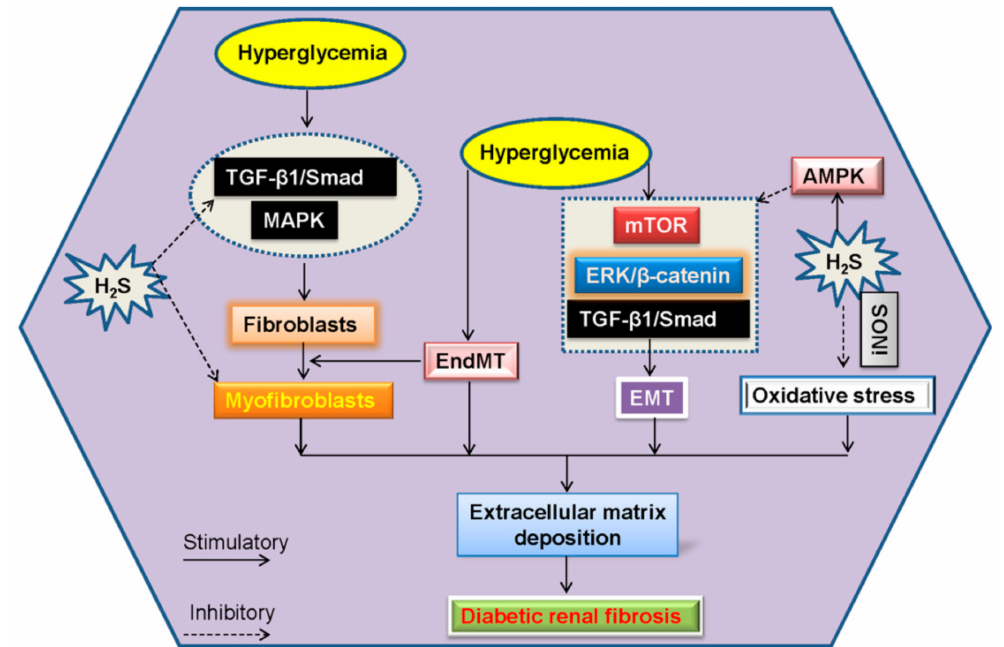
Figure 6. E ff ect of H 2 S on renal fibrosis in diabetic kidneys. Activated fibroblasts may be from resident quiescent fibroblasts via the process of EndMT. H 2 S treatment prevents the di ff erentiation of quiescent renal fibroblasts to myofibroblasts and myofibroblasts proliferation via inhibition of the TGF- β 1 / Smad and MAPK signaling pathways. Blockade of ERK- and β -catenin-dependent pathways may be involved in the protective e ff ect of H 2 S on the formation of EMT in renal tubular epithelial cells. In addition, H 2 S dose-dependently stimulates AMPK phosphorylation and induces its subsequent inhibition of mTORC1 activity. Induction of iNOS, is required for H 2 S to inhibit high glucose-induced oxidative stress and matrix protein generation in renal proximal tubular epithelial cells. EndMT, endothelial-mesenchymal transition; EMT, epithelial mesenchymal transition; TGF- β 1, transforming growth factor- β 1; MAPK, mitogen-activated protein kinase; mTORC1, mammalian target of rapamycin complex 1; ERK, extracellular regulated protein kinases; AMPK, adenosine 5’-monophosphate (AMP)-activated protein kinase; iNOS, inducible nitric oxide